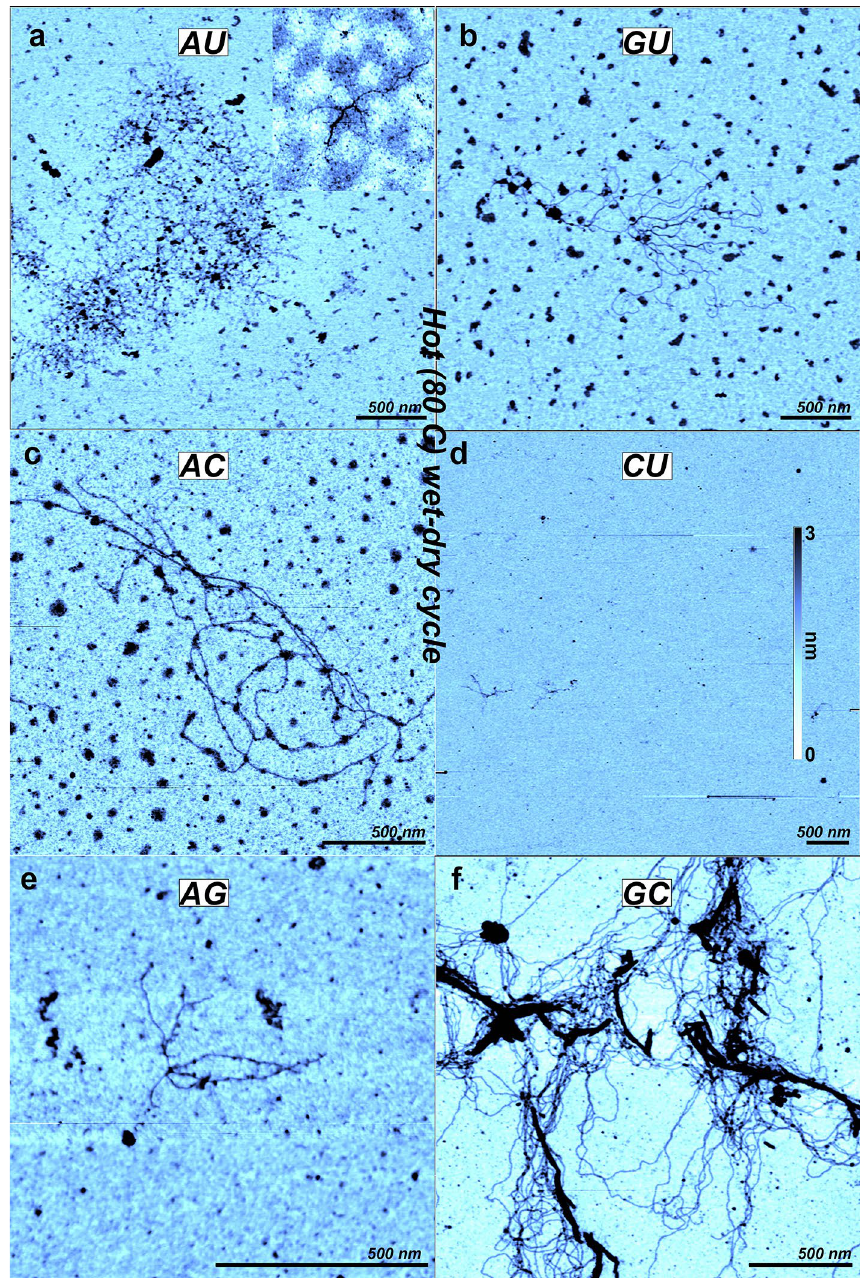
Figure 4. AFM images of 1:1 mixtures of 10 mM mononucleotides exposed to 3 wet-dry cycles on mica surfaces at 80 °C. ( a ) AMP + UMP. Two types of polymer structures are shown, one as an inset at the